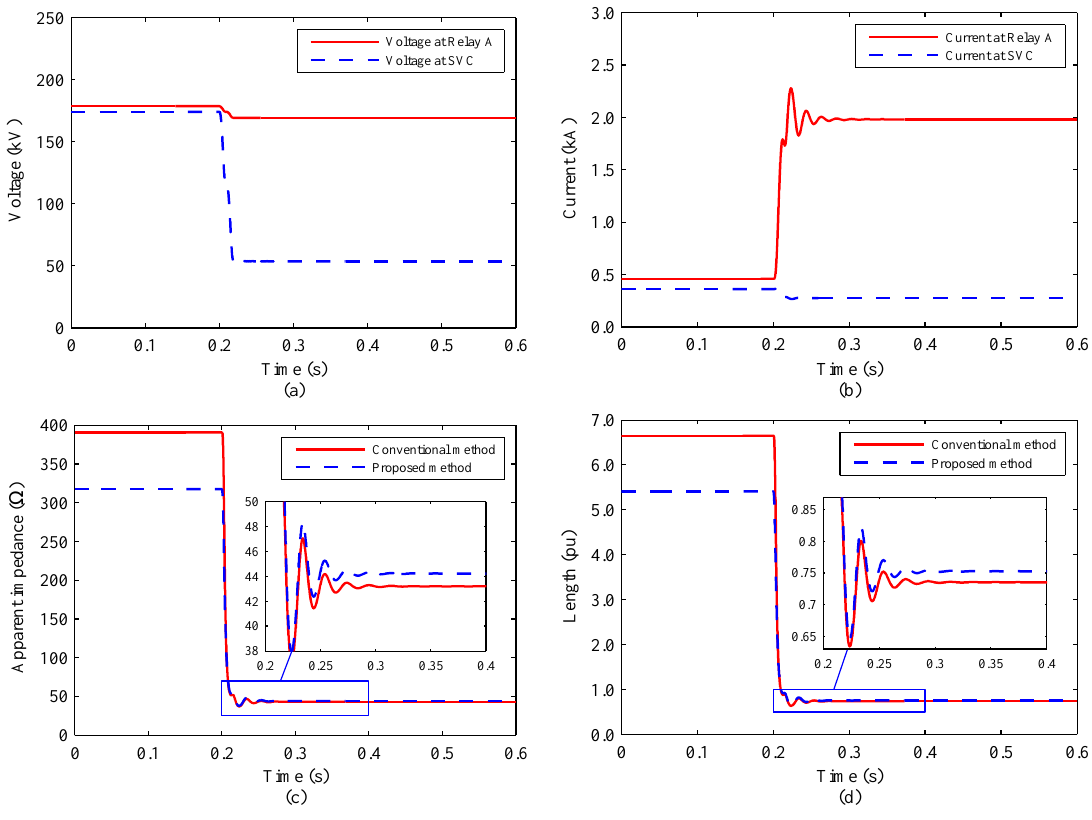
Figure 8. The simulation results of Case 2. ( a ) voltage measurement; ( b ) current measurement; ( c ) apparent impedance at relay A; ( d ) fault